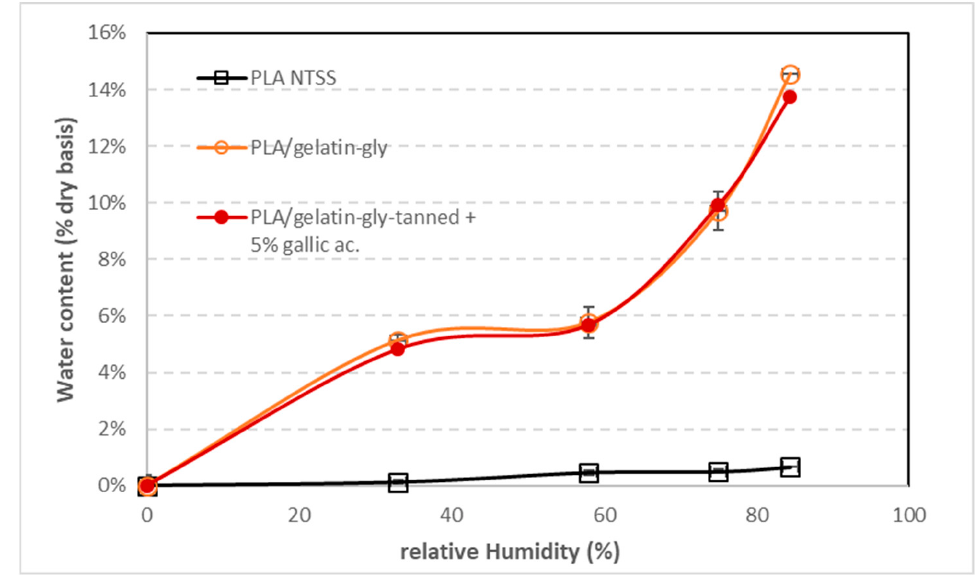
Figure 5. Moisture sorption isotherms of PLA films and of coated PLA films (PLA/gelatin-gly and PLA/gelatin-gly tanned + 5% gallic ac.), measured at 25 °C.